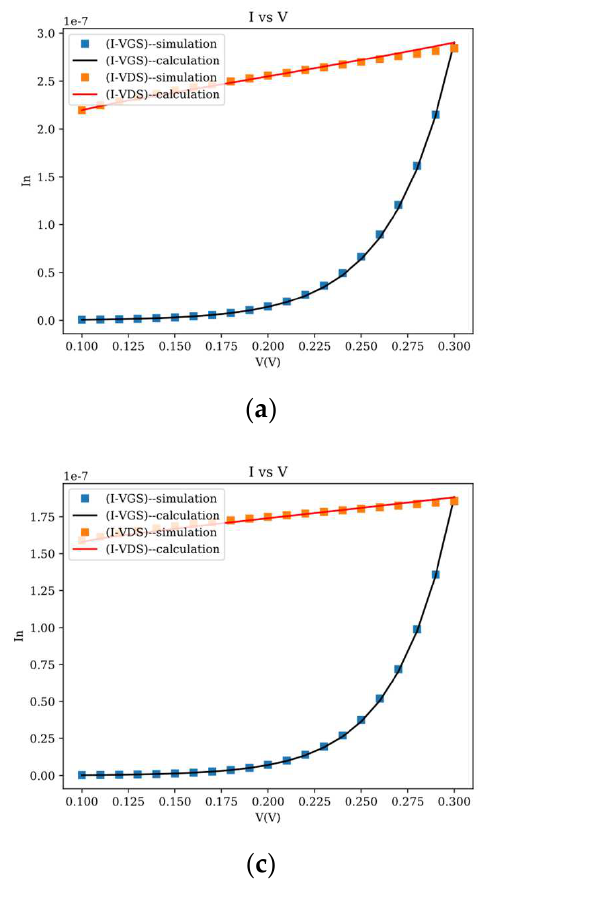
Figure A1. Current changes of transistors with voltage, where the symbols represent the DC simu- lation results and the lines represents the current formula calculation results. ( a ) Size 1; ( b ) size 2; ( c ) Size 3; ( d ) Size 4. Table A2. Size 1: Current data compared with simulation results. Table A3. Size 2: Current data compared with simulation Current (A)